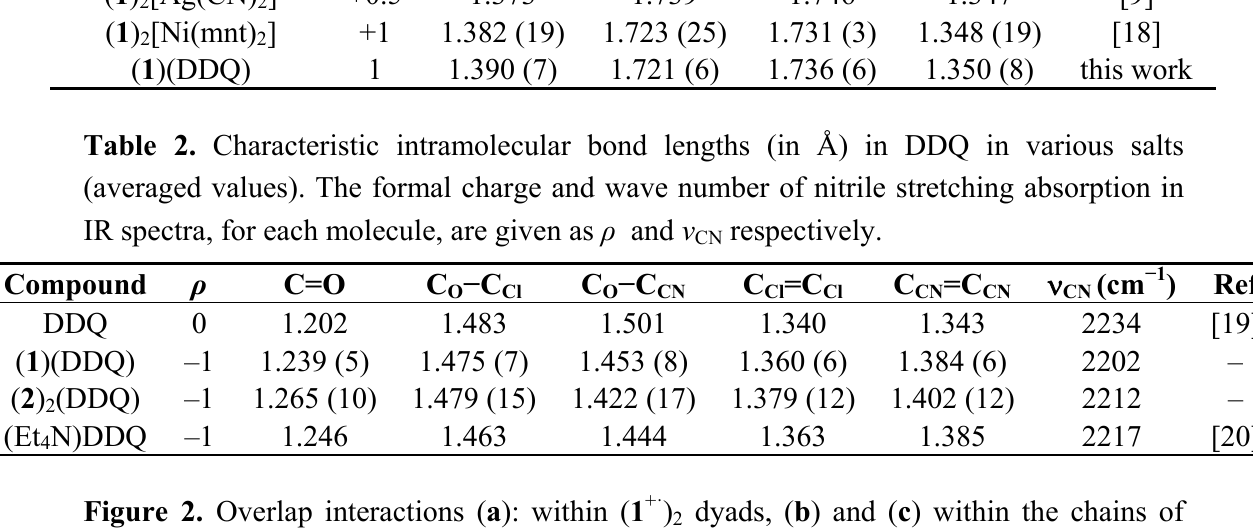
dyads, ( b ) and ( c ) within the chains of 2